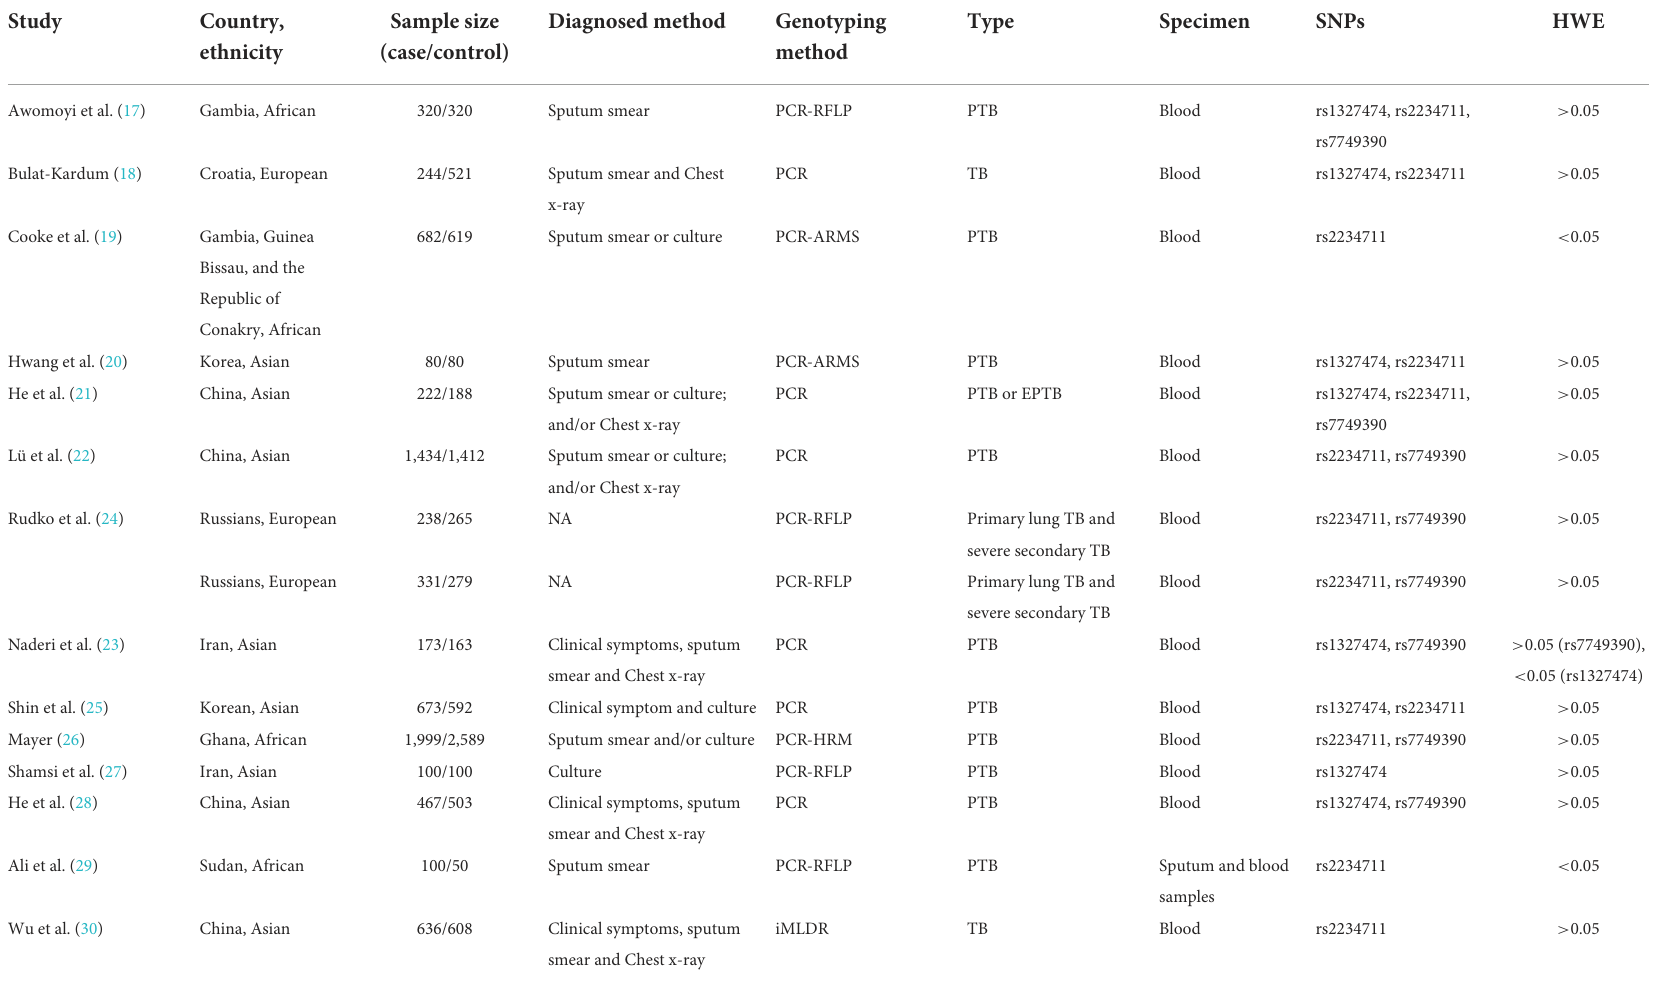
TABLE 1 Basic information of studies included in this